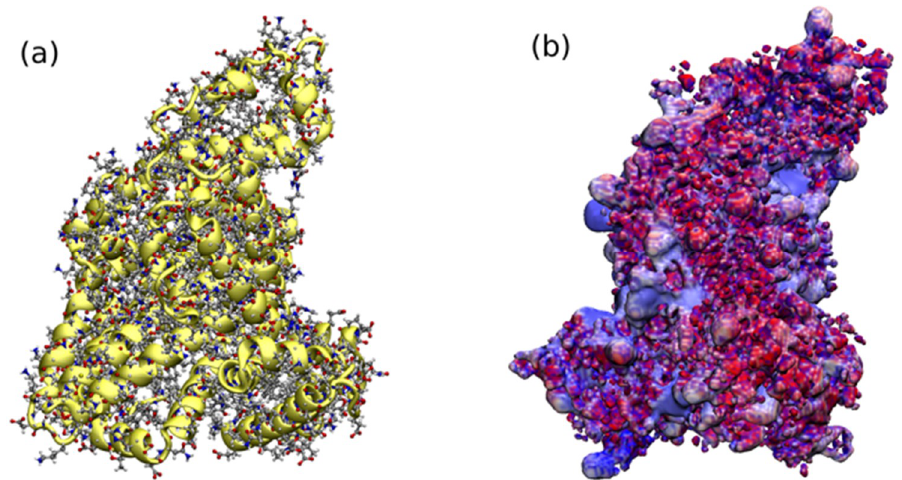
Figure 9. Visualization of the human albumin protein (pdb number 1AO6) in the protonation state at pH = 7. The structure of the protein in all atom (Licorice) and helical (NewCartoon) representation with shown outer functional groups ( a ). Electrostatic potential map of the protein [33] ( b ) depicts places in red and blue corresponding to the negatively and positively charged regions, respectively. Electrostatic potential was calculated using Adaptive Poisson-Boltzmann Solver (APBS) [34] with a default grid dimension, as implemented in APBS software. Hydrogen atoms and charges were placed according to pKa of amino acids using the CHARMM protein force field, and assigned protonation states at pH = 7 with PROPKA software, as implemented in the PDB2PQR server [35]. The visualization was made in VMD software using the RWB color scheme for the electrostatic potential map with isovalue 2 for the charge range (–3–+3).